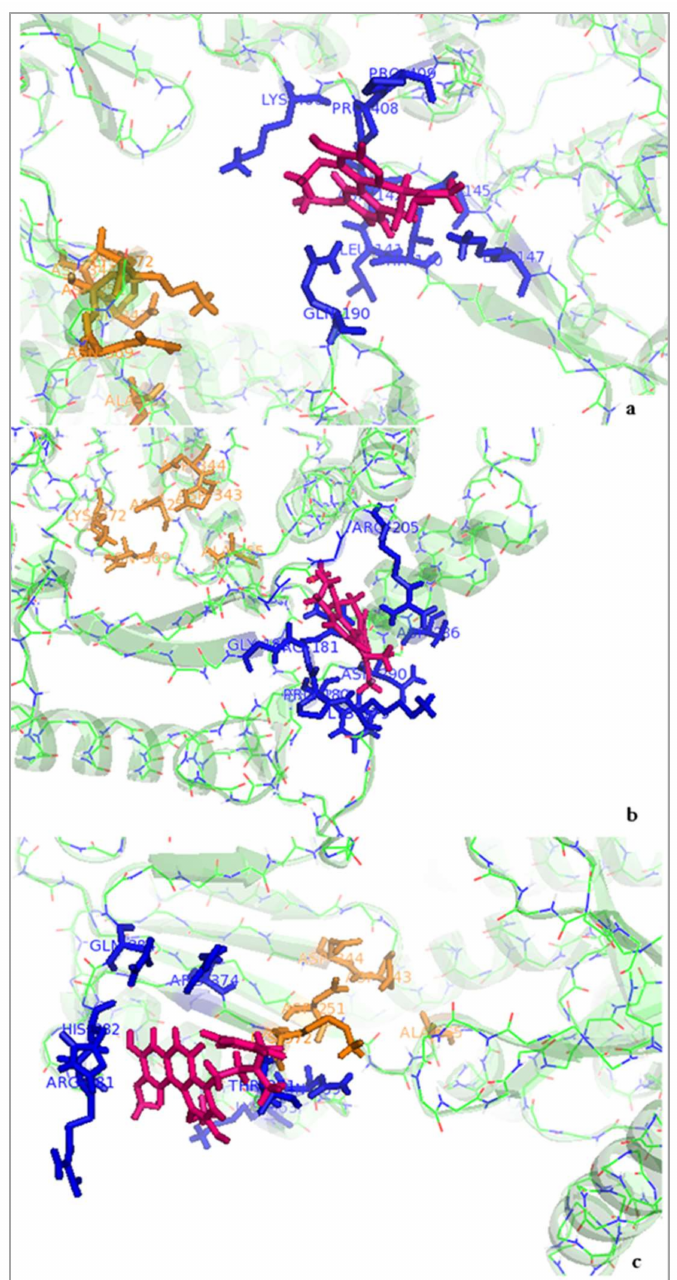
Figure 6. Interactions of Tc-telomerase with boldine or BSB (pink color) after 10 ns simulation; ( a ) boldine in complex with a new binding box (blue color) in finger domain of Tc-TERT that places it outside of the active site (orange color) (initial structure of boldine obtained from the focused docking screen); ( b ) boldine in complex with a new binding box (blue color) in the finger region of Tc-TERT that places it outside of the active site (orange color) (initial structure of boldine obtained from the blind docking screen); ( c ) BSB in complex with a new binding box (blue color) in the palm domain of Tc-TERT that places it outside of the active site (orange color) (initial structure of BSB obtained from the focused docking